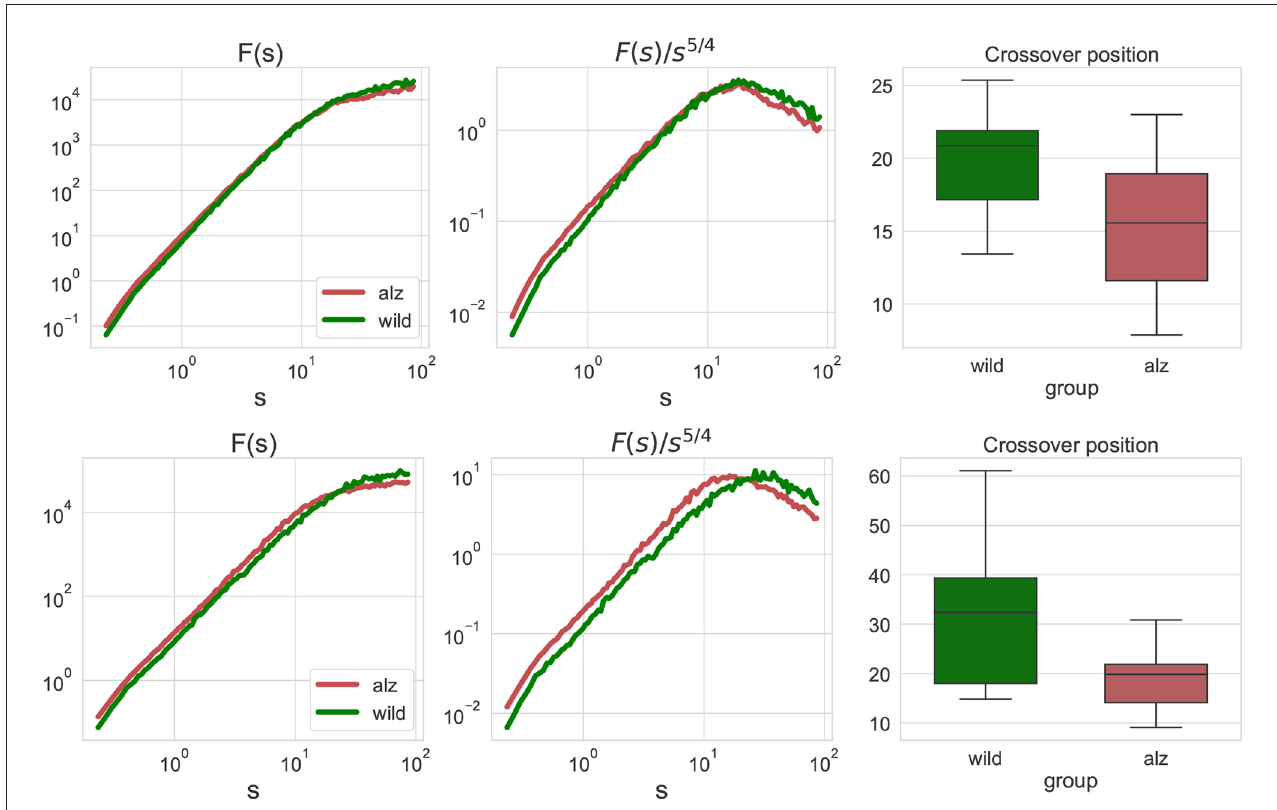
FIGURE2 Left: fluctuation functions F j , j ( s ) for the movement trajectories along the X-axis (upper) and Y-axis (lower) for all animal body parts j as denoted in Figure 1 obtained by detrended fluctuation analysis (DFA). The green curve denotes wild type mice (control group), while the red curve denote the Alzheimer mice cohort (test group). Fluctuation functions scale asymptotically as F ( s ) ∝ s 2 at small scales, and as F ( s ) ∝ s 1 / 2 at large scales. Middle: show the same fluctuation functions F ( s ) divided by s 5 / 4 used to determine the crossover position at the maximum of the rotated fluctuation function. Right: boxplots characterizing the crossover position statistics for all individual movement trajectories of each body part of each animal. Scales and crossover positions are expressed in